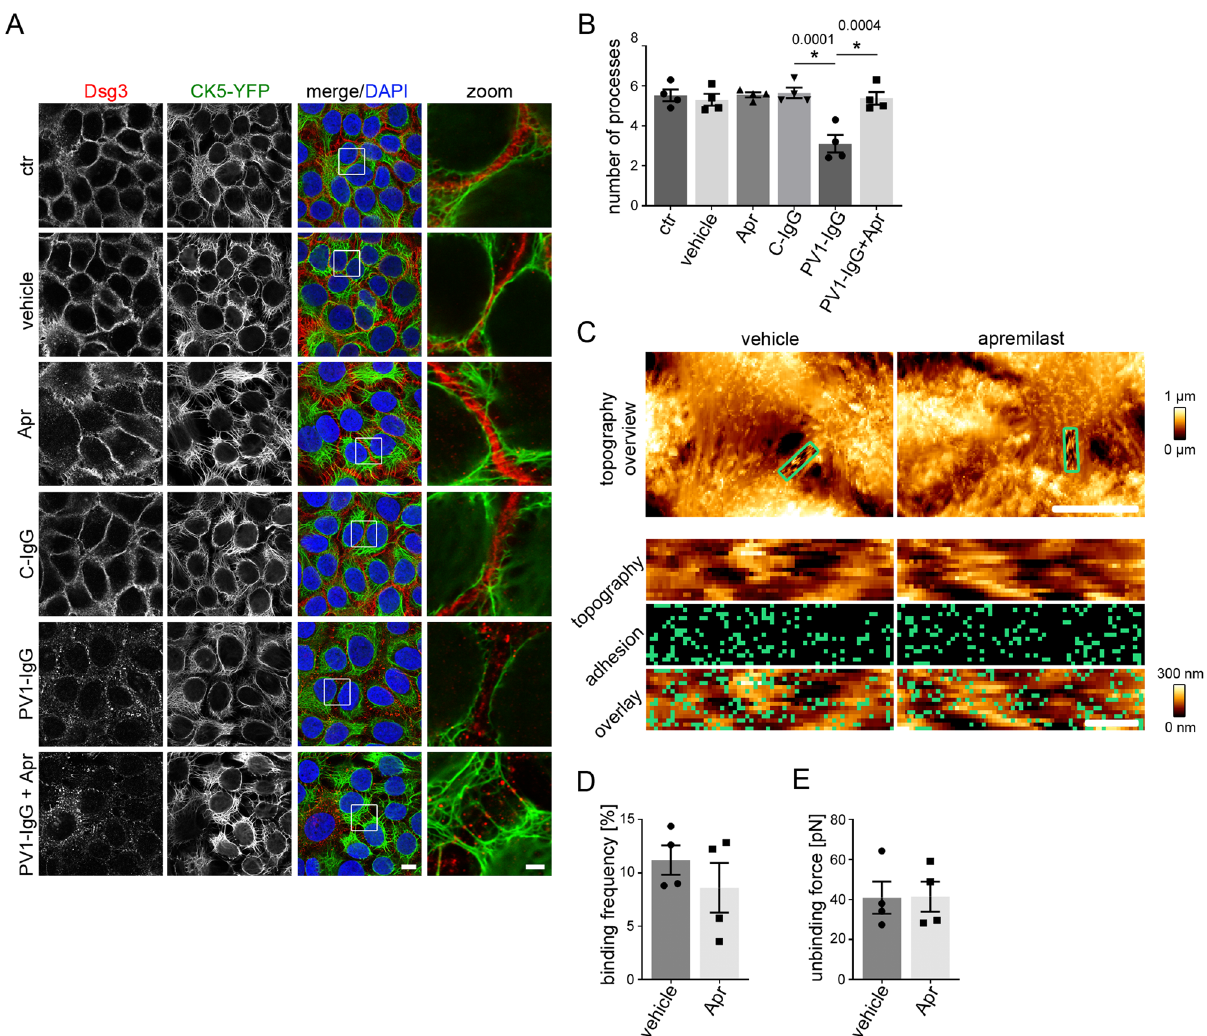
Fig. 3 | Apremilast restores PV1-IgG-induced retraction of the keratin cytos- keletonbuthasnoeffectonDsg3.A ImmunostainingofDsg3instablyexpressing CK5-YFP HaCaTs. Apremilast (100 µ M) prevented PV-IgG-induced retraction of the keratin cytoskeleton but not Dsg3 depletion and fragmentation of Dsg3 staining. Representative of n =4. Scale bar=10 µ m. Areas for zoom in marked with white rectangles. Scale bar (zoom)=2.5 µ m. B Quanti fi cation of the number of keratin- bearing processes over 10 µ m of the membrane. Pretreatment of apremilast restored PV1-IgG-induced decreased number of keratin-bearing cell processes ( n =4). C Topography overview images of atomic force microscopy (AFM) mea- surements on living HaCaTs using a Dsg3-functionalized tip revealing cell borders bridgedbydense fi lamentalstructures.Scalebar=10 µ m.Smallareasalongthecell